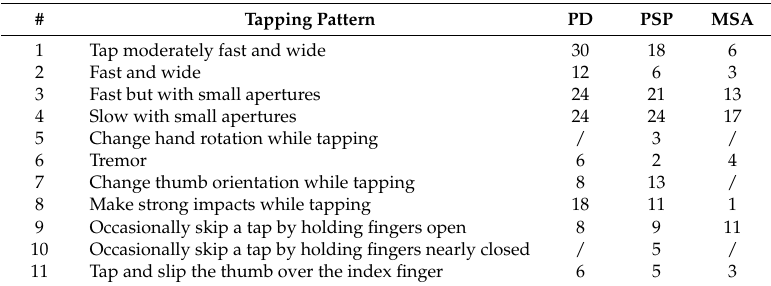
Table 1. Typical tapping patterns and events identified from the pilot study, and their numbers of occurrences within the observed patient